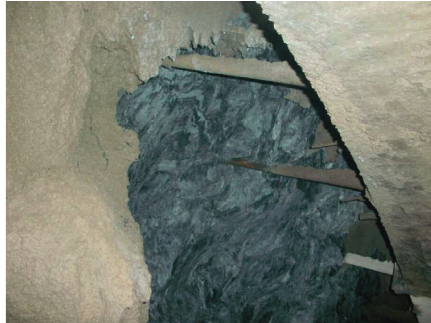
Figure 1: Sericite